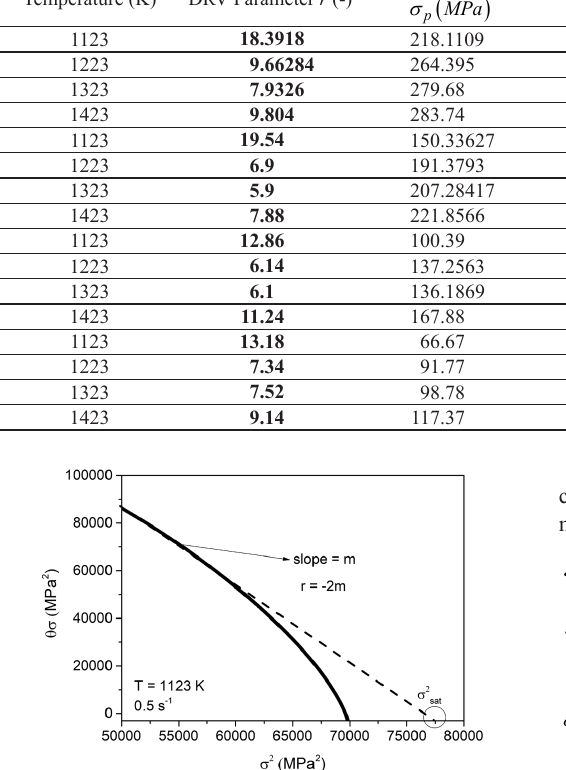
Table 2. Dynamic recovery parameter ( r ) obtained from the flow curves of DIN 18MnCrSiMo6-4. Temperature (K) DRV Parameter r (-)